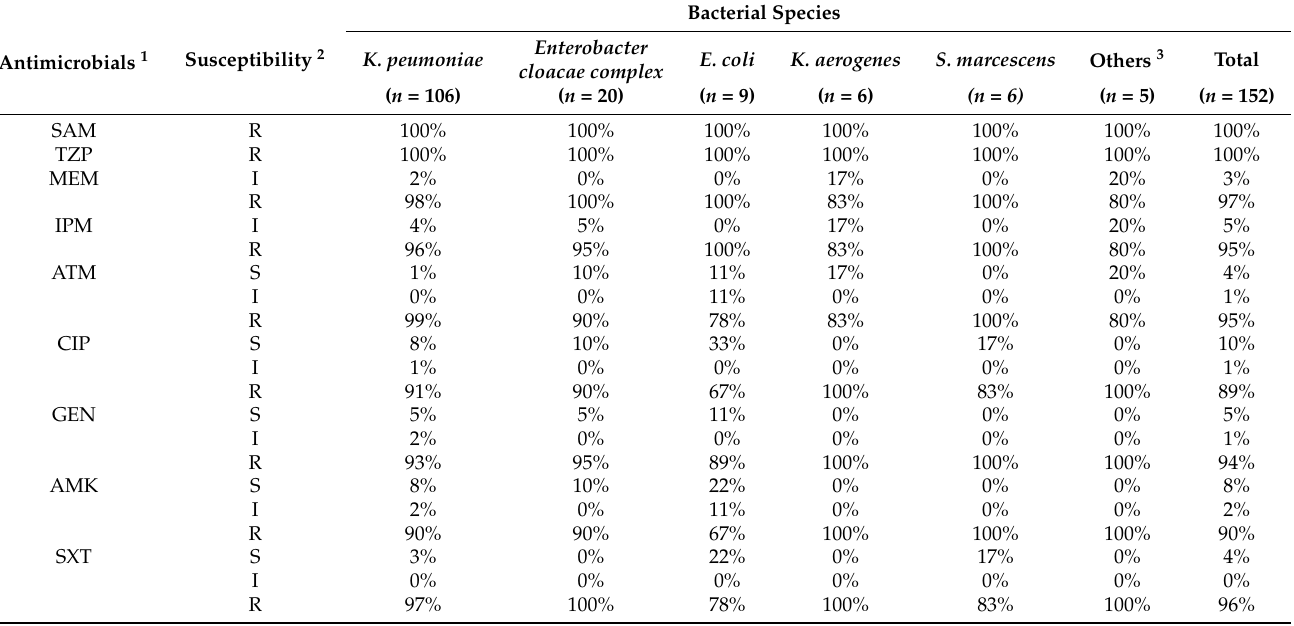
Table 1. Antimicrobial susceptibility rate (%) of CPE isolates ( n = 152) from 2016 to 2021, Havana, Cuba.